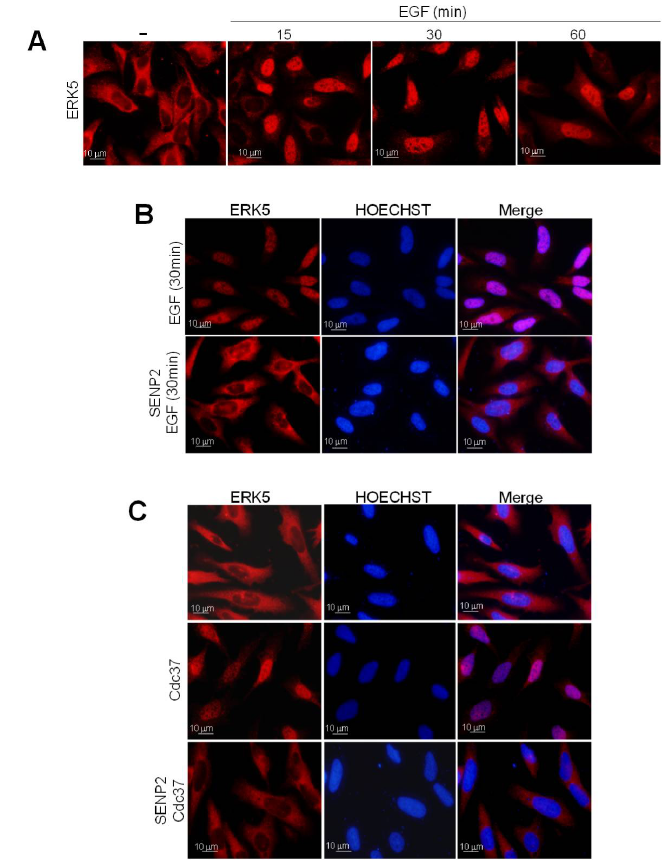
Figure 3. Overexpression of SUMO peptidase SENP2 inhibits nuclear translocation of endogenous ERK5. (A) ERK5 nuclear translocation in response to epidermal growth factor (EGF). PC-3 cells were